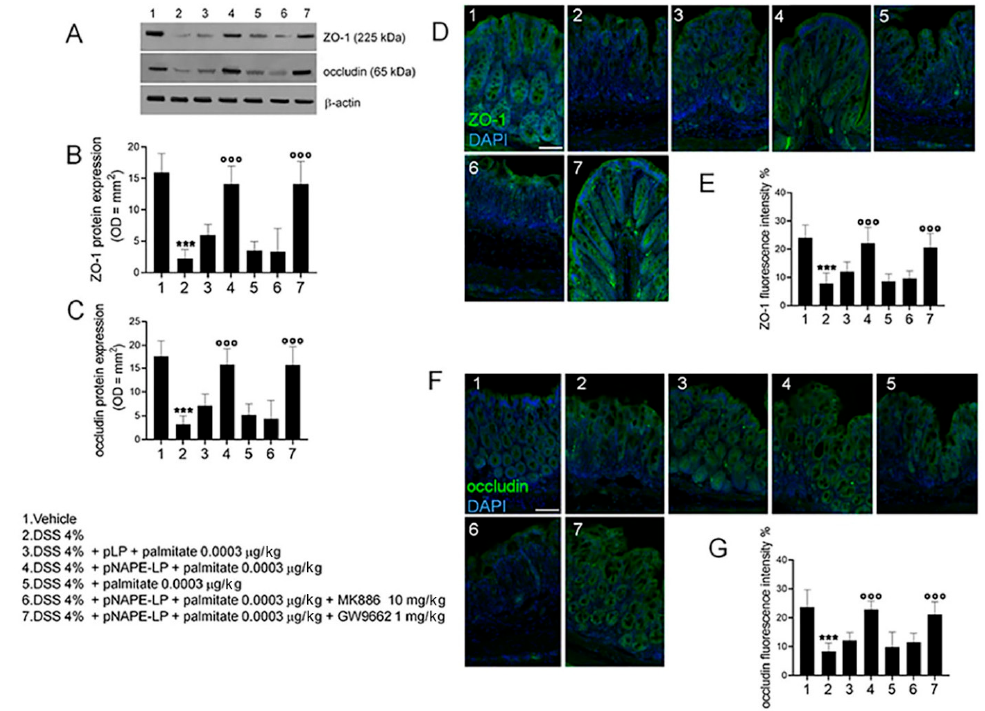
Figure 4. PEA released from pNAPE-LP + palmitate prevents the loss of tight junction proteins ZO-1 and occludin and colonic barrier disruption. ( A ) Immunoreactive bands and ( B , C ) relative densitometric analyses (arbitrary units normalized on the expression of the housekeeping protein β -actin), as well as immunofluorescence staining and their respective quantification corresponding to ( D , E ) ZO-1 and ( F , G ) occludin, showing the effects of pNAPE-LP combined to palmitate (0.0003 μ g/kg), given alone or in the presence of MK886 (10 mg/kg) or GW9662 (1 mg/kg) on colonic mucosa of DSS-treated mice. Palmitate alone (0.0003 μ g/kg) failed to significantly affect ZO-1 and occludin expression in colonic mucosa. Nuclei were also investigated using DAPI staining. Results are expressed as the mean ± SD of n = 5 experiments performed in triplicate. *** p < 0.001 versus vehicle; °°° p < 0.001 versus DSS-treated mice. Scale bar = 100 μ m; magnification 10×.